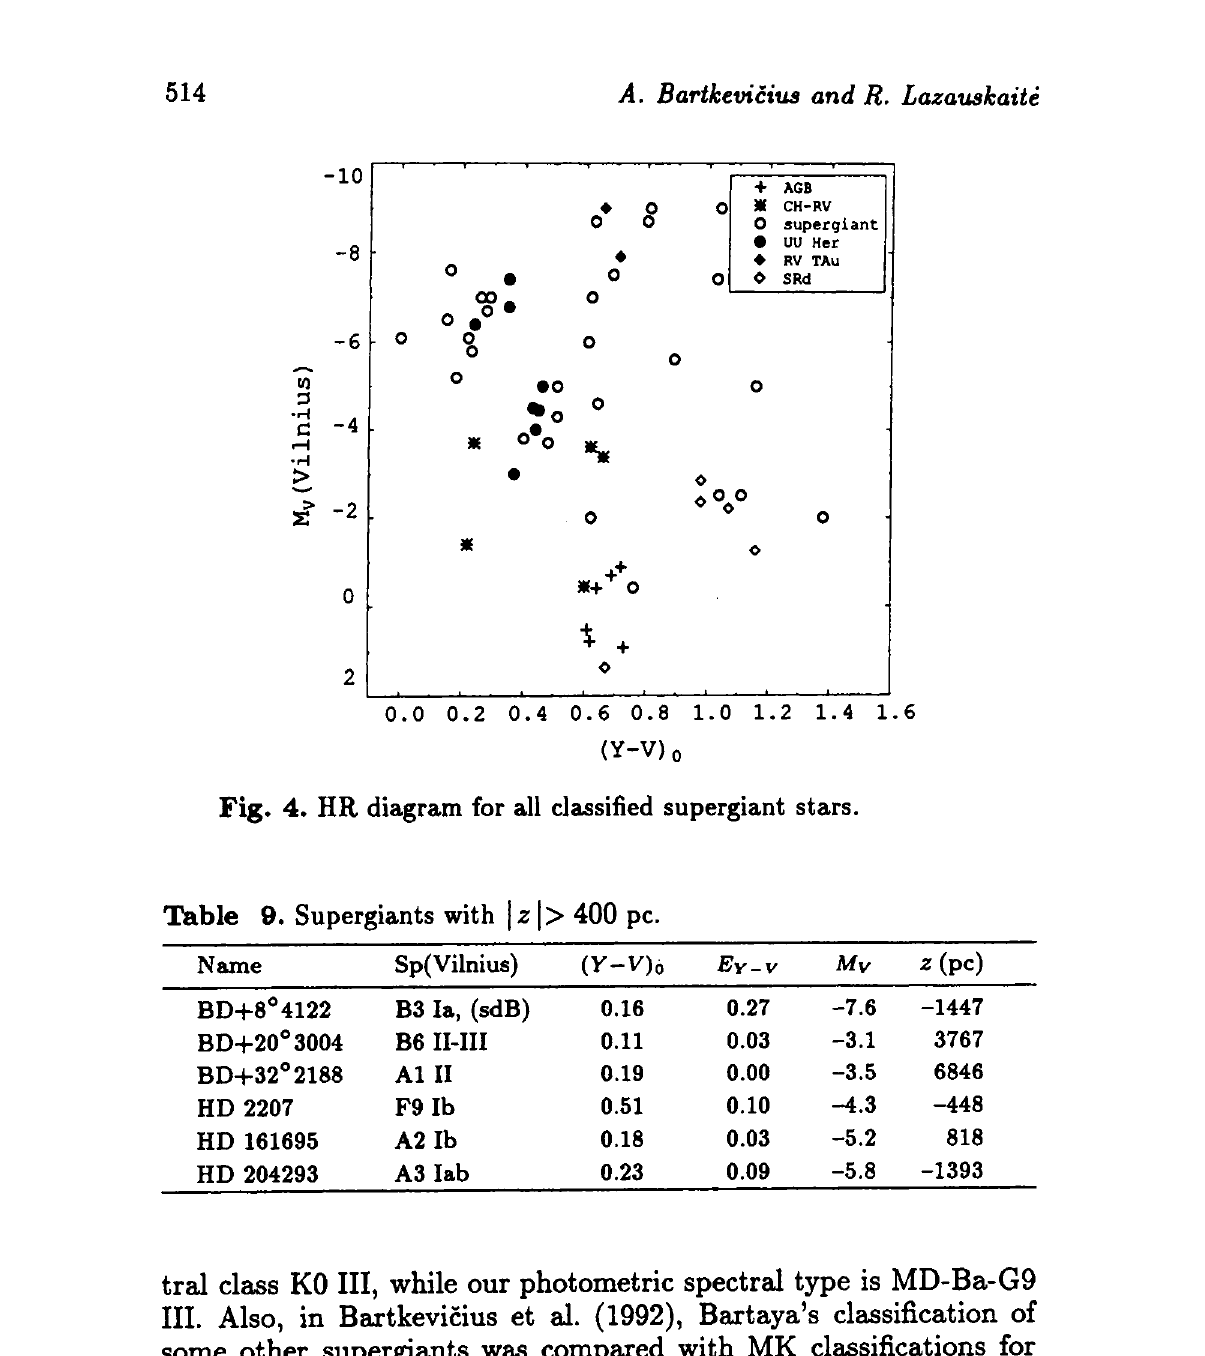
Table 9. Supergiants with \z\> 400